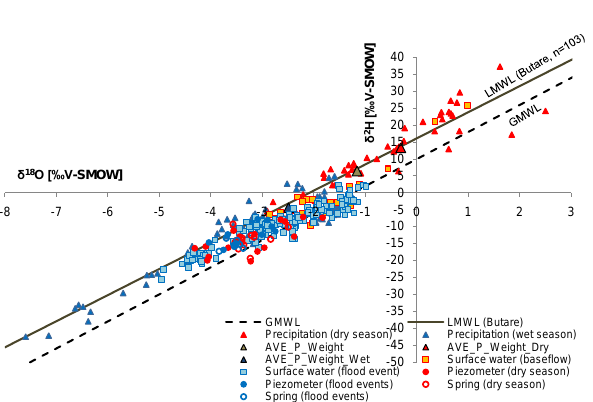
Table 4. Isotope concentrations observed at the Kansi sub-catchment and at the Migina catchment during the investigated research period (from 1 May 2009 to 31 June 2011); n represents the number of samples; the entries in brackets represent the standard deviation values. Rainfall Surface water Groundwater Springs ( n =145) ( n =173) ( n =28) ( n =18) Parameter Unit Kansi Migina Kansi Migina Kansi Migina Kansi Migina Isotopes δ 2 H (‰) − 16.9 (21.3) − 7.8 (16.6) − 11.4 (7.3) δ 18 O (‰) − 4.3 (3.6)